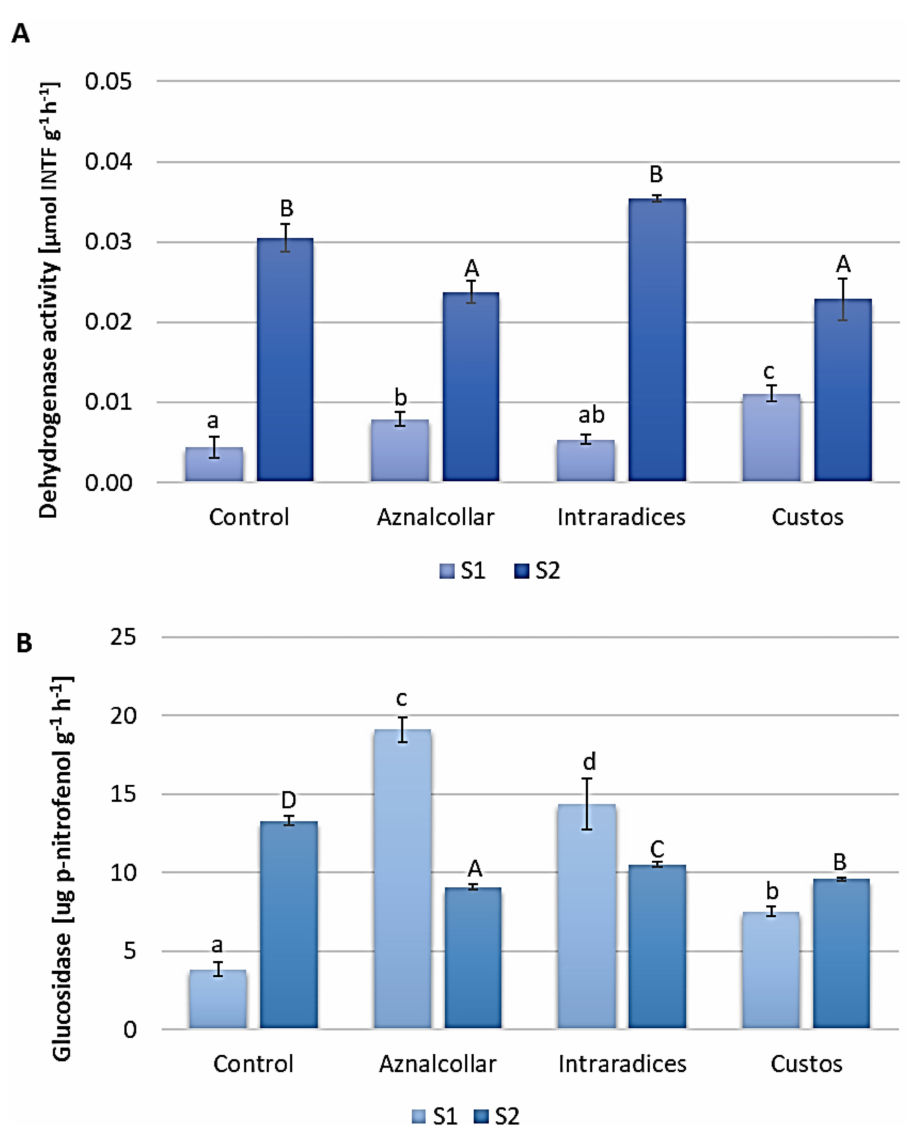
Figure 2. Enzymatic activity measured in soils 1 and 2 (S1 and S2) inoculated with the three AMF selected (Aznalcollar, Intraradices, and Custos): ( A ) dehydrogenase; ( B ) ß-glucosidase. Error bars rep- resent one standard deviation from the mean ( n = 3). Different letters indicate significant differences between treatments ( p < 0.05) according to the Duncan post-hoc test; lowercase for S1 and capital letters for